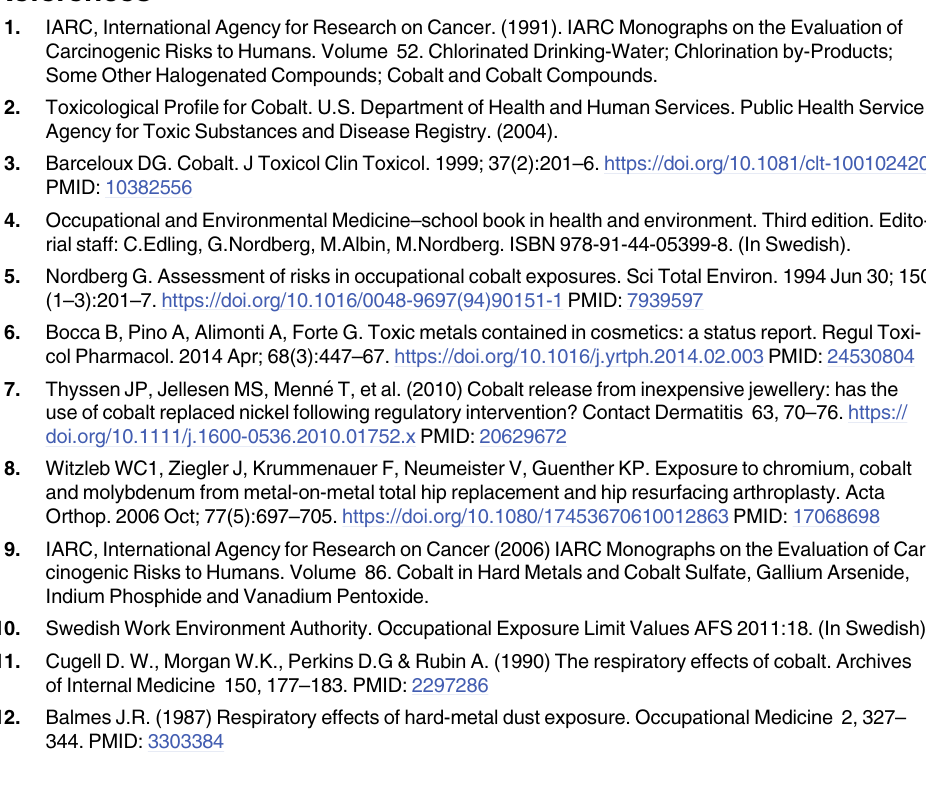
S1 Fig. Flow chart of the study’s